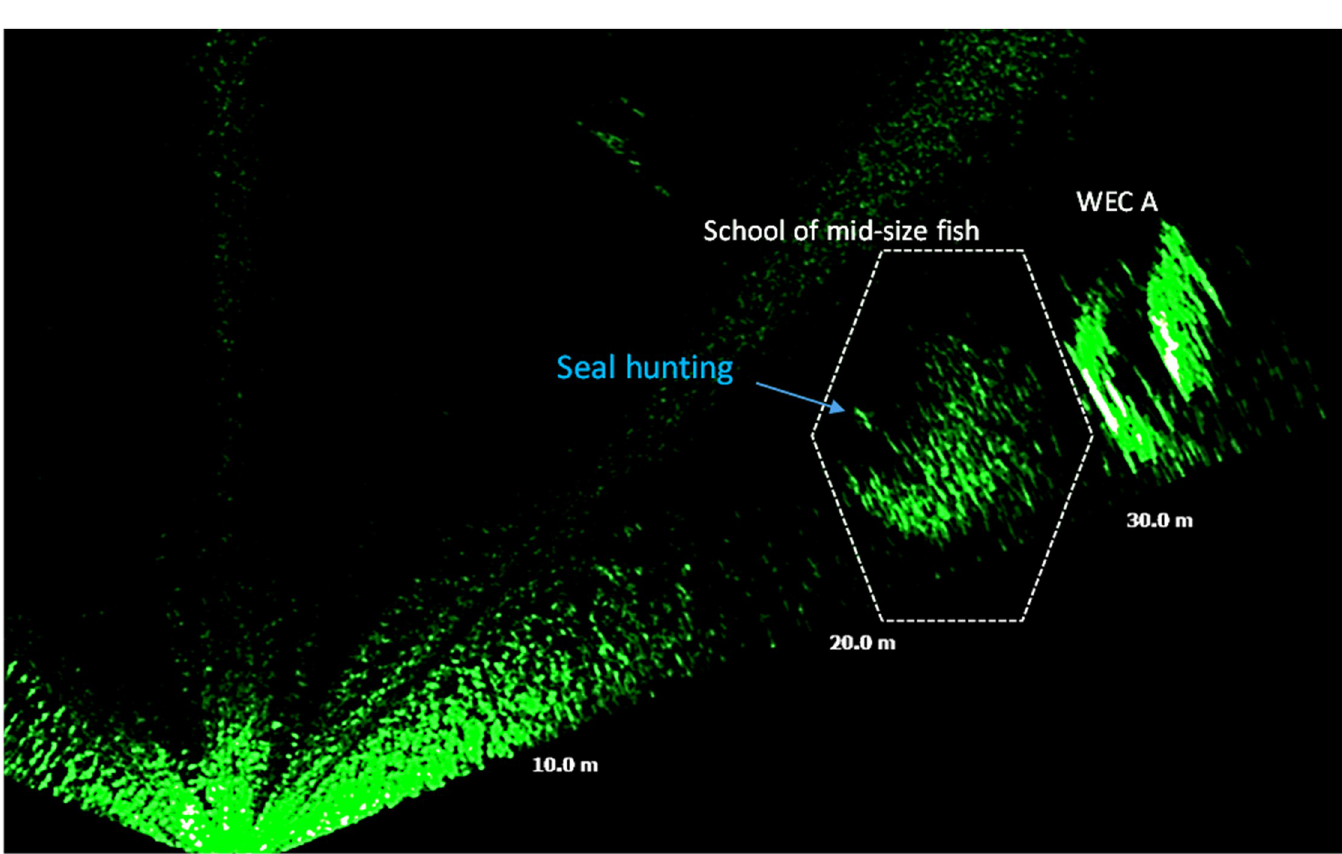
Fig 14. Acoustic image acquired on 27/08/16 at 09:22 UTC, showing a school of mid-size fish passing close to WEC A. A hunting seal measuring 2.5 m of length, was detected hunting and diving into the school.